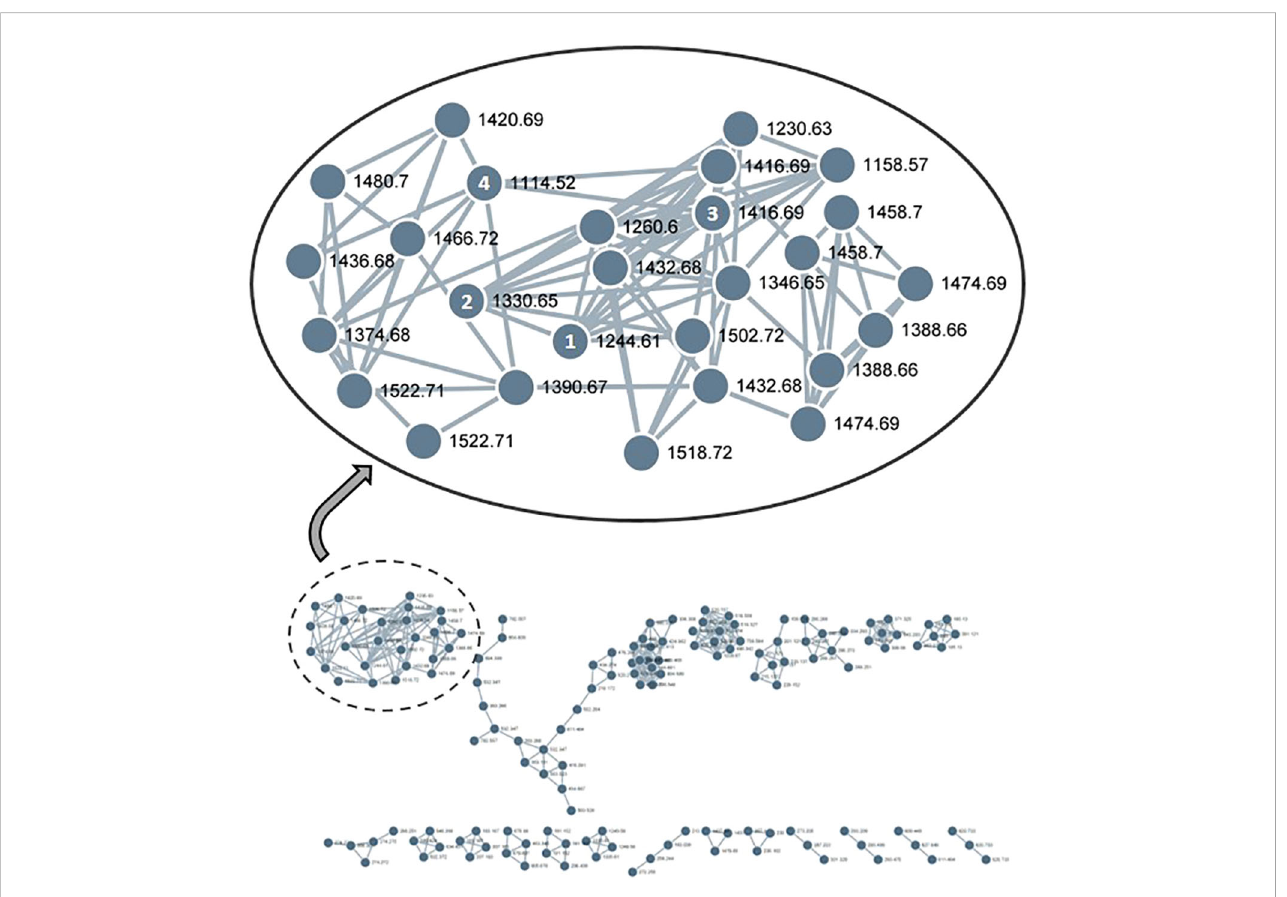
FIGURE 3 GNPS-cluster assigned to pannoside analogs from methanol extract of Tripolium pannonicum . 21 nodes composed the cluster, excepting overlaps. Numbers on nodes mean compounds 1 – 4 . 1 , pannoside A ( m / z 1244.6 [M + NH 4 ] + ); 2 , pannoside B ( m / z 1330.6 [M + NH 4 ] + ); 3 , pannoside C ( m / z